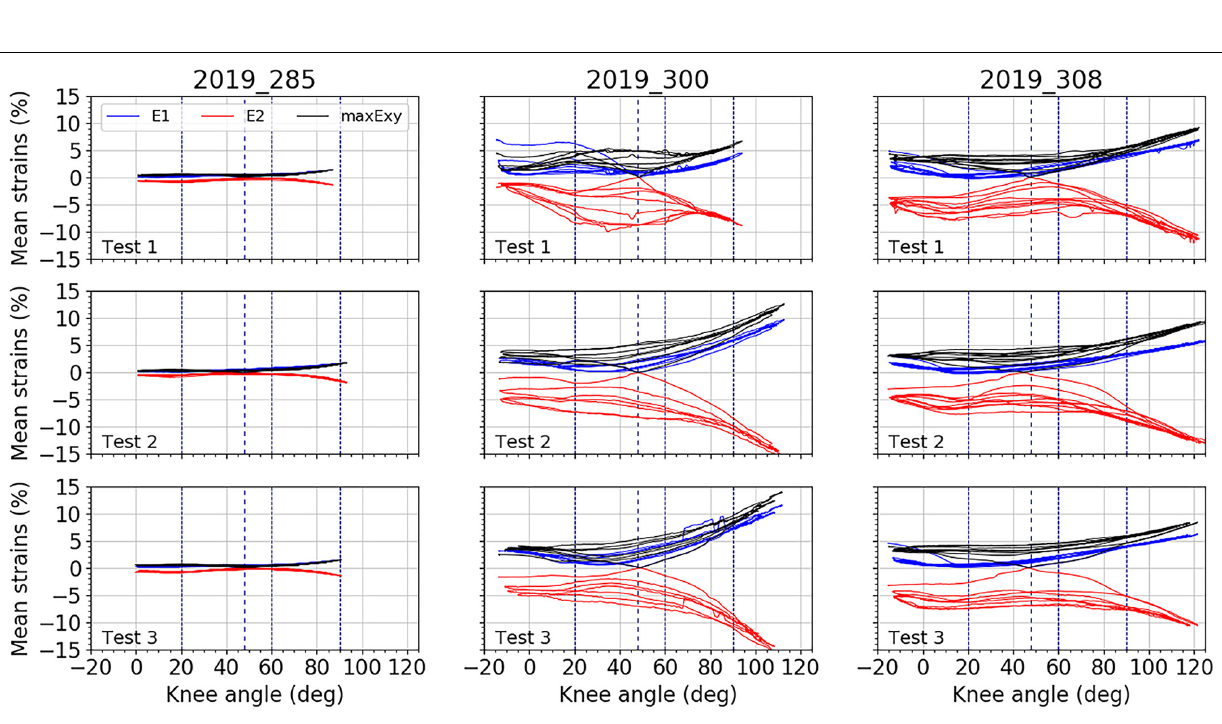
FIGURE 5 | Mean strain distributions over the knee angles for the anterior fascia. In blue, mean major principal strain E 1 , in red, minor principal strain E 2 , and in black, maximal shear strain maxE xy . For each test, all cycles are plotted. Vertical dashed line represents the knee position chosen as reference: 47 ◦ . Three other vertical lines locate knee angles of 20 ◦ , 60 ◦ , and 90 ◦ .